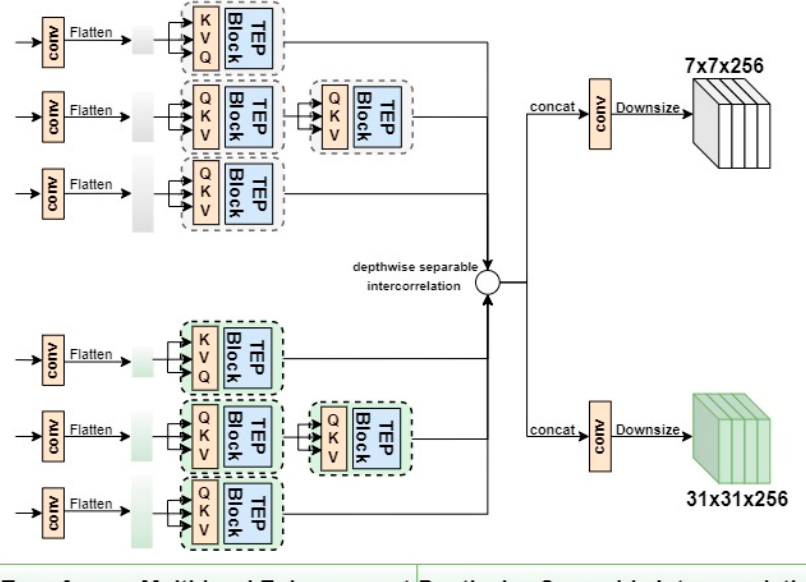
Figure 6. The schematic of the process of Transformer multi-level enhancement, depthwise separable intercorrelation, and downsize operation.